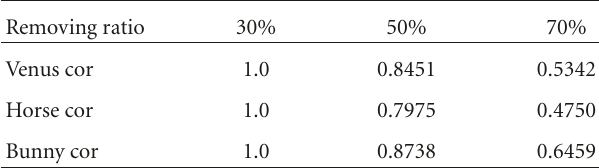
Table 1: Results of simplification attacks.